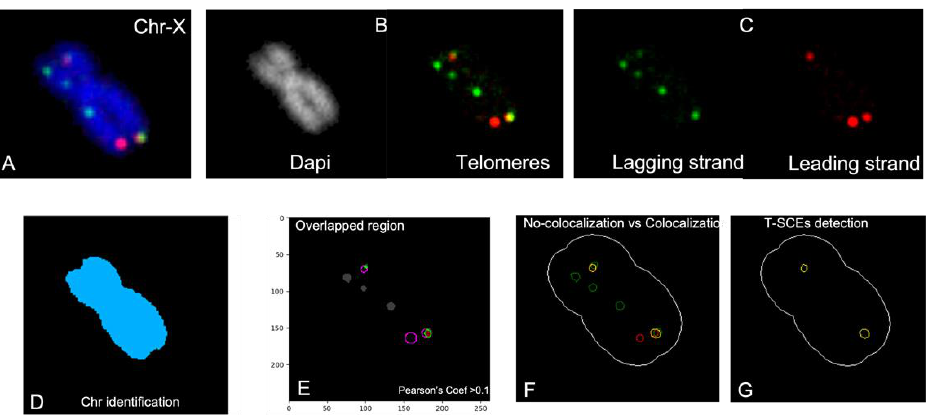
Figure 1. T-SCE analysis: ( A ) Image showing a chromosome counterstained with DAPI (blue), and the leading (red) and lagging (green) strand telomeres. For the detection of T-SCEs we customized a CellProfiler pipeline that identifies chromosomes ( B ) (in grayscale) and telomeres (in red and green). The separation of the channels allowed the software to count (C ) green signals (lagging strand telomeres) and red signals (leading-strand telomeres). Digitalization of ( D ) chromosomes and telomere signals were required to calculate ( E ) overlapped regions with a Pearson’s coefficient > 10%. The outcome of the analysis shows ( F ) the number of green and red signals, as well as the number of ( G ) colocalized signals representing T-SCEs.